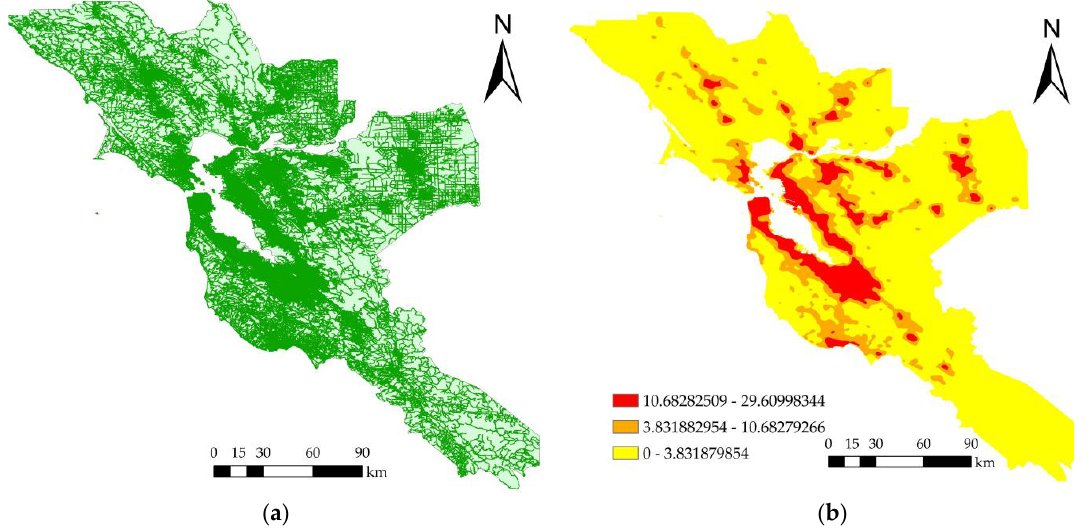
Figure 5. Kernel density analysis: ( a ) San Francisco Bay region road network; ( b ) Results of kernel density analysis.